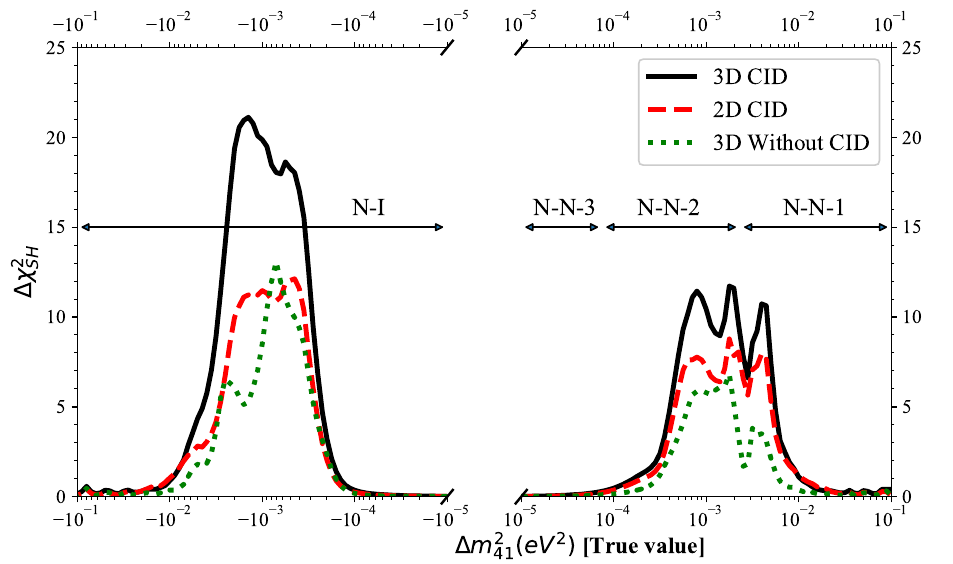
Figure 11 . The potential for identi(cid:12)cation of the sign of (cid:1) m 2 quanti(cid:12)ed by (cid:1) (cid:31) 2 [see eq. (5.2)]. The mixing parameters are taken to be j U e 4 j 2 = 0 : 025, j U (cid:22) 4 j 2 = SH 0 : 05, and j U (cid:28) 4 j 2 = 0. The results have been presented with and without muon charge identi(cid:12)cation, and with and without using the hadron energy